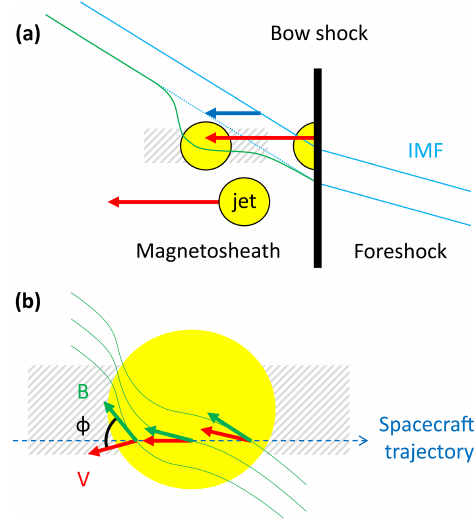
Figure 1. (a) Sketch of how magnetic fields in the magnetosheath may be modified by the motion of fast plasma jets. Velocities of jets and ambient plasmas are illustrated by red and blue arrows, respec- tively. In this paper, magnetic and velocity fields within the hatched area are evaluated. This figure is based on Fig. 12 in Plaschke et al. (2017). (b) Close-up on a jet. Green and red arrows show local directions of the magnetic-field B and velocity V measured by a spacecraft on its trajectory through the jet. The angle between B and V is φ B , V